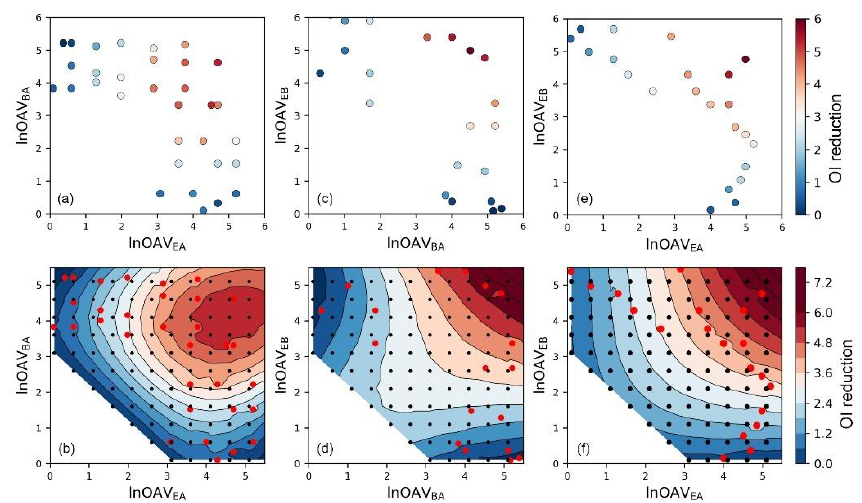
Figure 2. The scatter plot of the relationship between olfactory measured odor intensity reduction degree ( OI reduction ) and components’ ln OAV (natural logarithm of odor activity value) values, and corresponding contour map after adding SVR model predicted data (in the contour map, red dots: olfactory measured data; black dots: SVR predicted data) for binary mixture ( a , b ) EA + BA, ( c , d ) BA + EB, and ( e , f ) EA+EB.